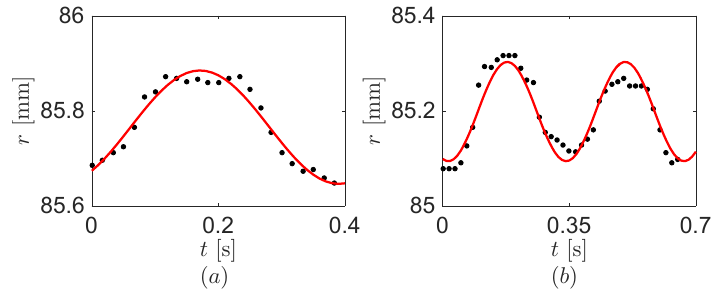
Figure 8. The distance r between the tip and the metacarpophalangeal (MP) joint of the robot finger. ( a ) One click and ( b ) double click. Black dots and red lines are the experimental data and its fundamental harmonics, respectively.